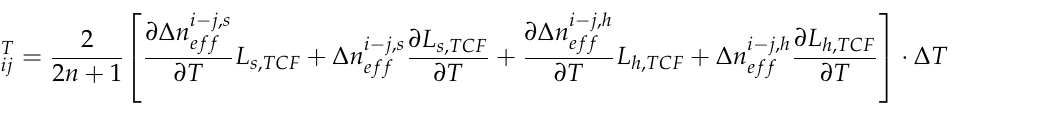
Figure 4. The real product and schematic diagram of the sensing system.